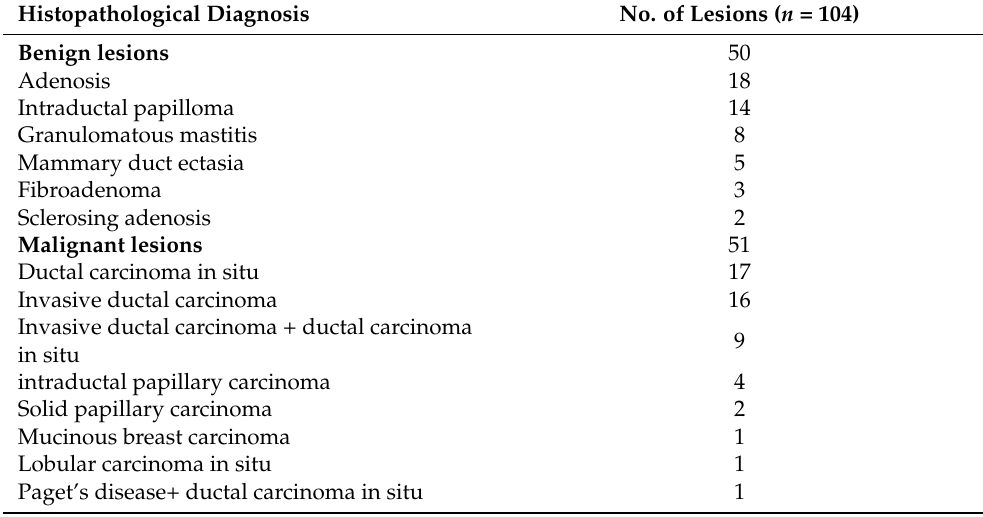
Table 1. Histopathological results.